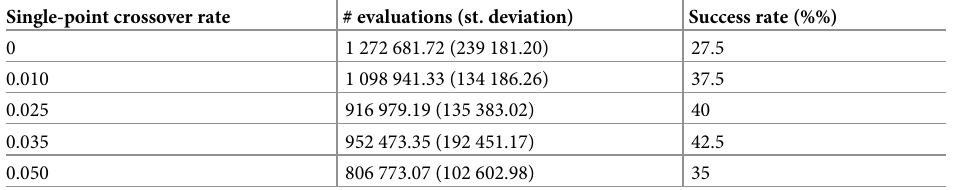
Table 2. Effectiveness (number of evaluations) and success rate for the competitive BioRS by means of standard GA with a single-point